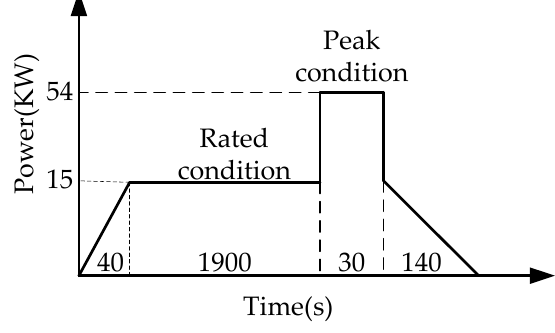
Figure 15. Schematic diagram of cycle conditions.